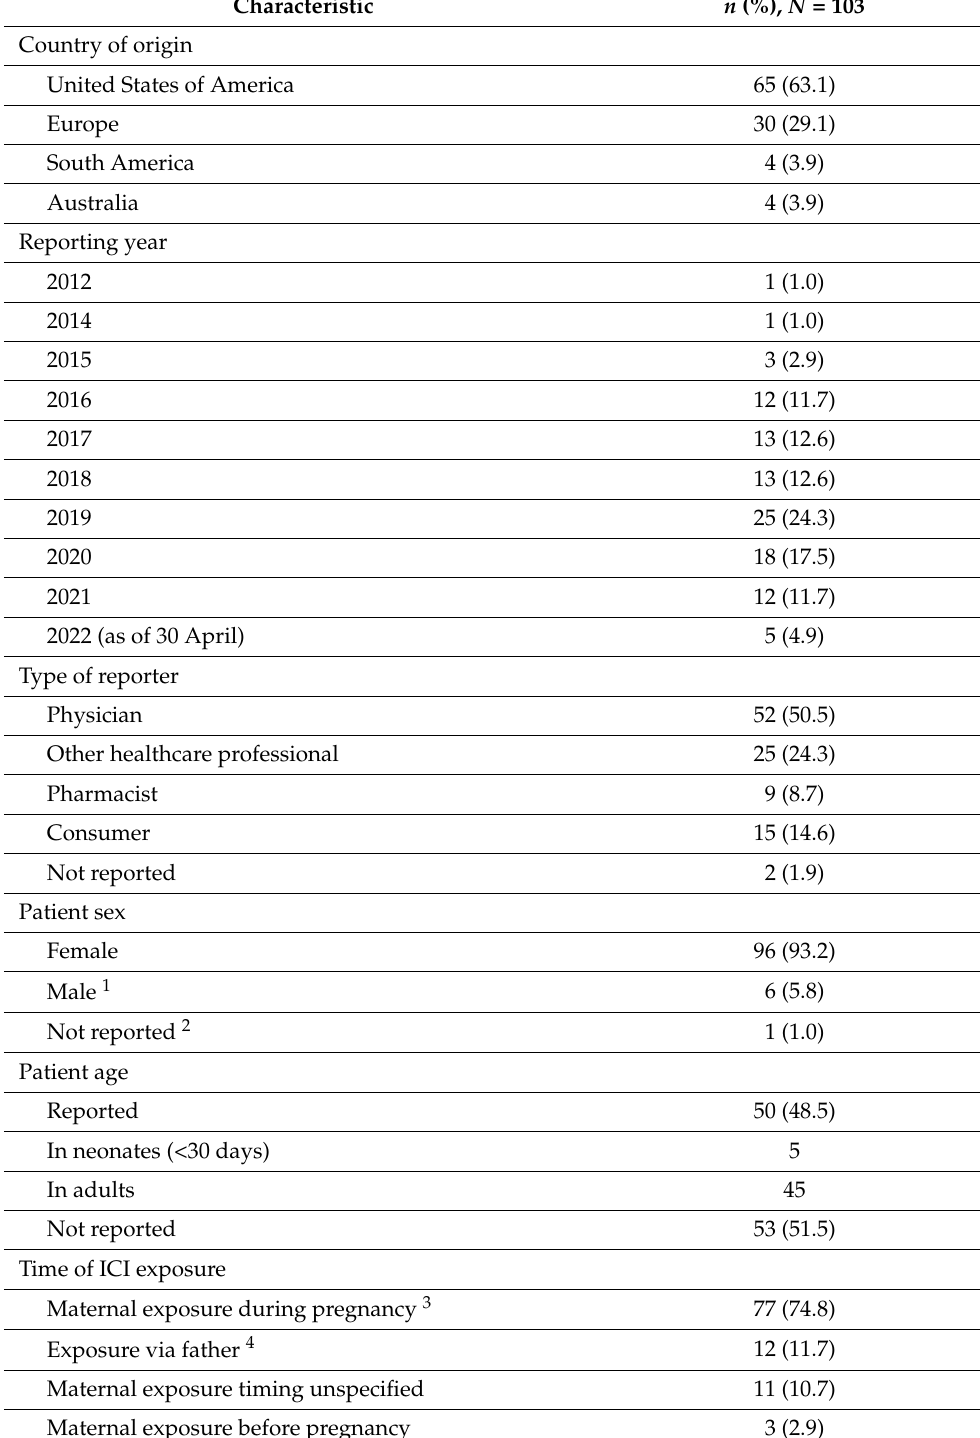
Table 1. Demographic and clinical characteristics of the safety reports included in the